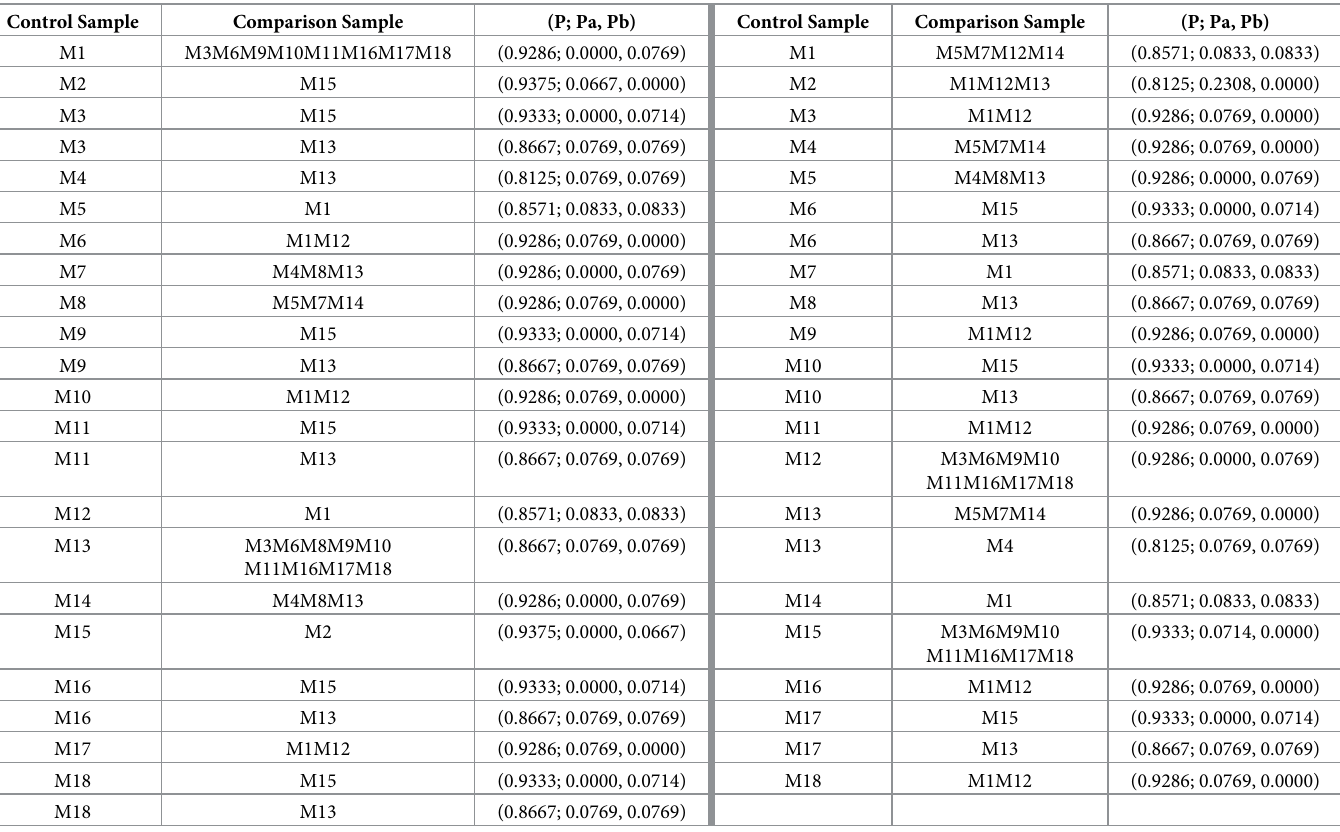
Table 6. The sequence with high common peak rate and low variation peak rate (Group